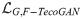
Evaluation results using the tLP metric for MRMNet and TecoGAN-G on four different data sets.The loss function used is LG,F−TecoGAN.